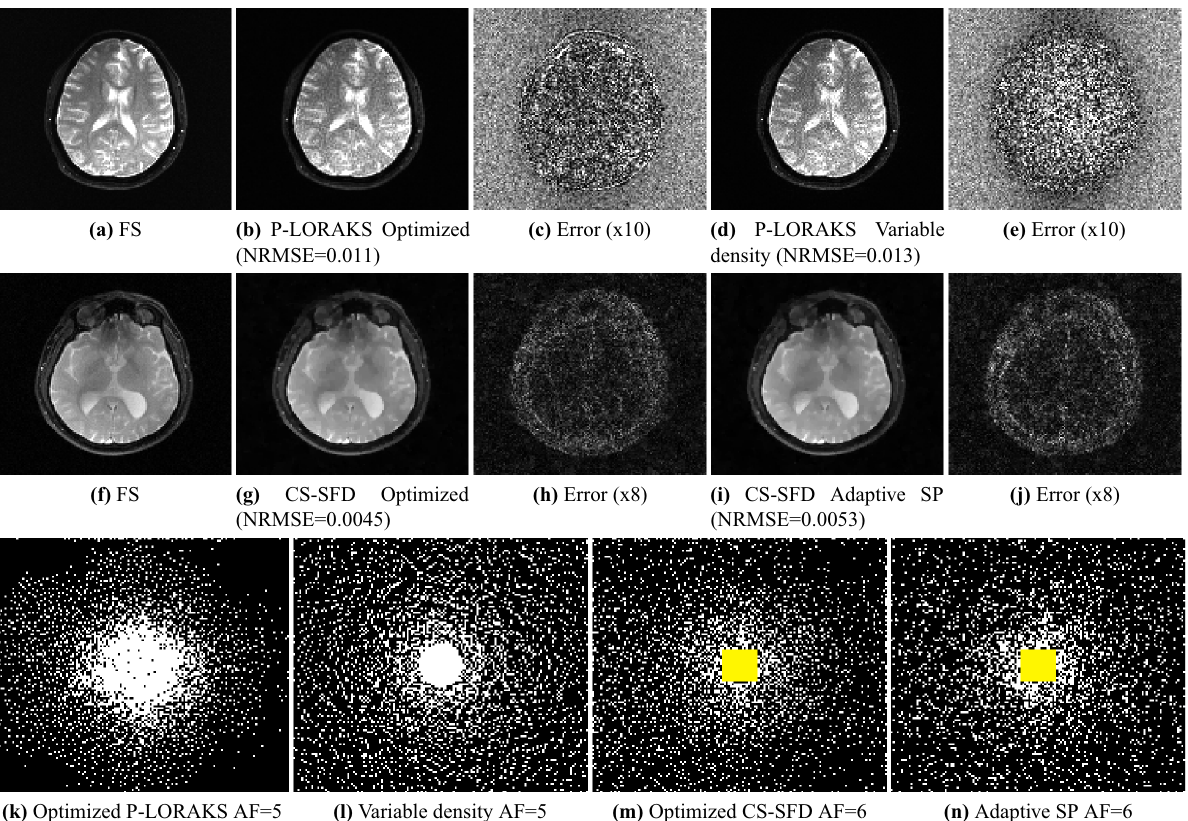
Figure 7. Visual results of the T 1 ρ -brain dataset are shown in this figure. For P-LORAKS, fully sampled (FS) reference is shown in ( a ), and images using optimized SP and variable density SP with AF = 5 are shown in ( b ) and ( d ). Error maps between FS and P-LORAKS are shown in ( c ) for Optimized SP and ( e ) for variable density SP. For CS-SFD, FS reference is shown in ( f ), and images using optimized SP and adaptive SP with AF = 6 are shown in ( g ) and ( i ). Error maps between FS and CS-SFD are shown in ( h ) for Optimized SP and ( j ) for adaptive SP. The optimized and variable density SP with AF = 5 for P-LORAKS are shown in ( k ) and ( l ), while the optimized and adaptive SPs with AF = 6 used for CS-SFD, with the highlighted central-square auto- calibration region, are shown in ( m ) and ( n